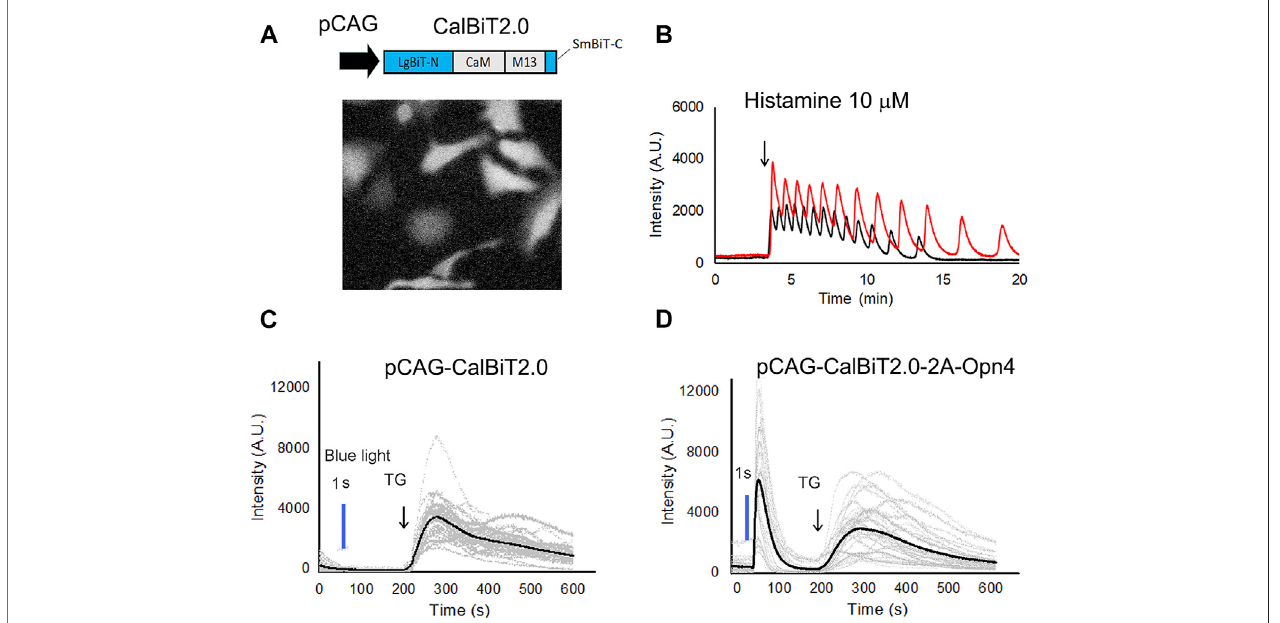
FIGURE 4 | CalBiT2.0 as a Ca ++ sensor in mammalian cells. (A) CalBiT2.0 construct driven by the CAG promoter (pCAG) for mammalian cell expression (upper), and snap-shot photomicrographsofHeLacellsexpressing CalBiT2.0during theadditionoffurimazine substrate and10 μ Mhistamineintomedia(below). (B) TwoHeLa cells(redandblacktraces,respectively)transfectedwiththepCAG-CalBiT2.0plasmid.Thesignalintensityofthetwocellsshowedout-of-phaseoscillationsinresponse to 10 μ M histamine. The arrow shows when histamine was added. See also Supplementary Movie S1 . (C) and (D) Monitoring Ca ++ fl uxes with CalBiT2.0 in response to an optogenetic actuator (melanopsin encoded by Opn4 ) and/or an agent that releases store-operated Ca ++ (thapsigargin, TG). HEK293 cells transfected with pCAG-driven construct encoding CalBiT2.0 alone (C) or transfected with bicistronic pCAG-driven construct encoding CalBiT2.0 and melanopsin ( Opn4 , (D ). Both groups of cells in (C and D) were exposed to blue light (blue line) for 1 s, followed by the addition of 1 μ M thapsigargin (at the time indicated by the arrow and “ TG ” ). The gray lines represent the signal intensity for each cell as a function of time, and the black line represents the average signal intensity of all cells. HEK293 cells that do not expressmelanopsin(panel C )didnotexhibitaCa ++ fl uxinresponsetothebluelightpulse,butHEK293cellsthatadditionallyexpressmelanopsin(panel D )showedlarge Ca ++ changes in response to optogenetic actuation. Both the groups of the HEK293 cells exhibit large and persisting changes in signal intensity in response to stimulation of store-operated Ca ++ release by